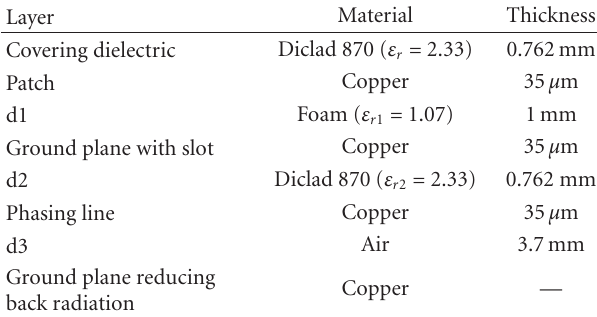
Table 4: Element